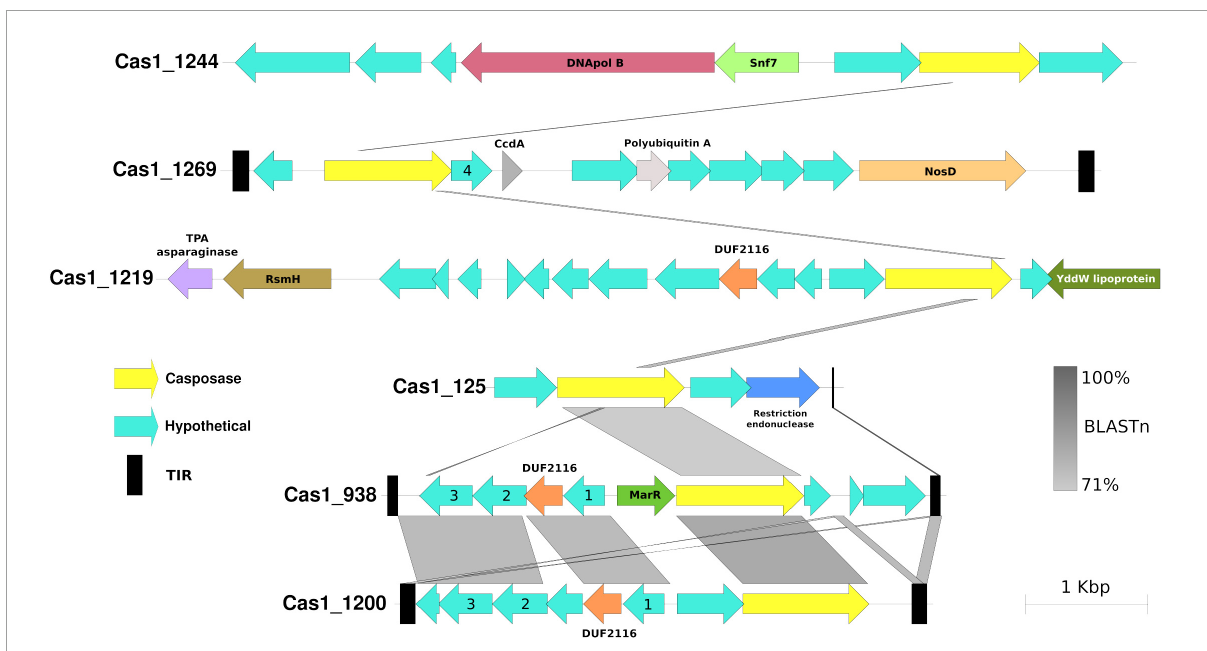
FIGURE7 Genetic neighborhood comparison of family 5 casposase genes from hot springs. Casposase gene ID is indicated at the beginning of the contig, and the BLASTn pairwise percentage is indicated according to the color shade. The legend indicates casposases (yellow), hypothetical proteins (aqua green), and terminal inverted repeats (black). Hypothetical proteins with numbers inside refer to the same protein sequence (another hypothetical protein number 4 can be found in Supplementary Figure 6 , Cas1_18 of family 3 casposases). TIRs could not be identified in Cas1_1219 and